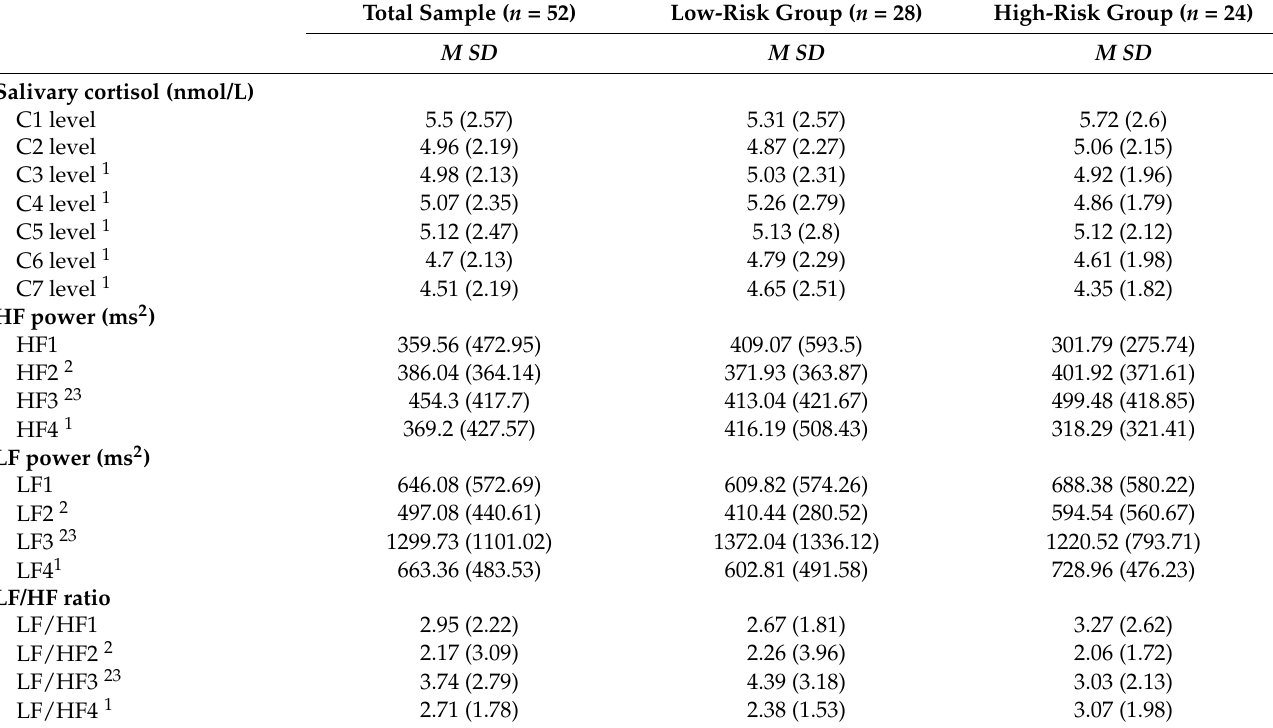
Table 1. Descriptive characteristics of the psychophysiological stress